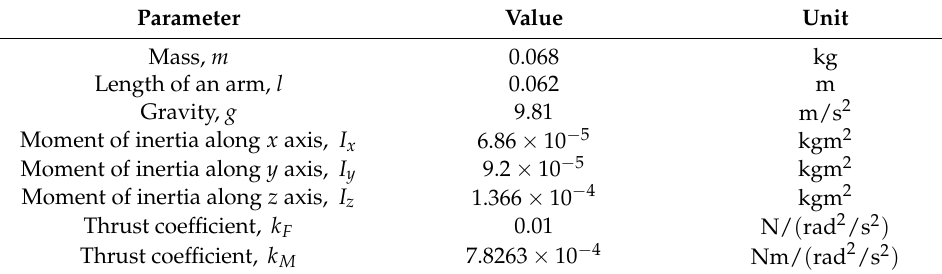
Table 1. Parrot mini-drone inertial parameters